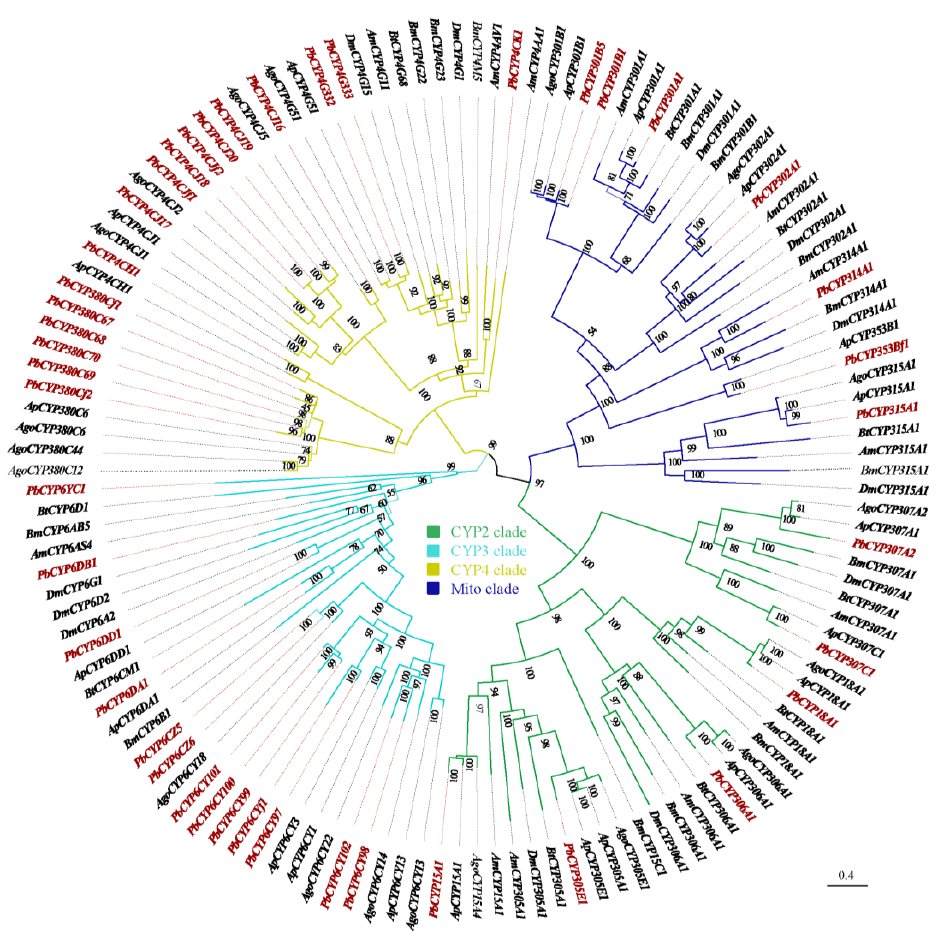
Figure 4. Phylogenetic relationship of P450 genes from Pseudoregma bambucicola (Pb), Acyrthosiphon pisum (Ap), Aphis gossypii (Ag), Bemisia tabaci (Bt), Drosophila melanogaster (Dm), Bombyx mori (Bm), and Apis mellifera (Am). Bootstrap support values are indicated by numbers on nodes of phylogenetic tree. The P450 genes of Pseudoregma bambucicola are marked in red in the figure.